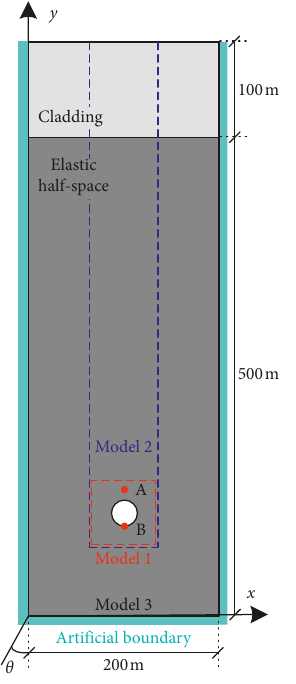
Figure 10: Model of the deep underground cavity in the layered half-space site.